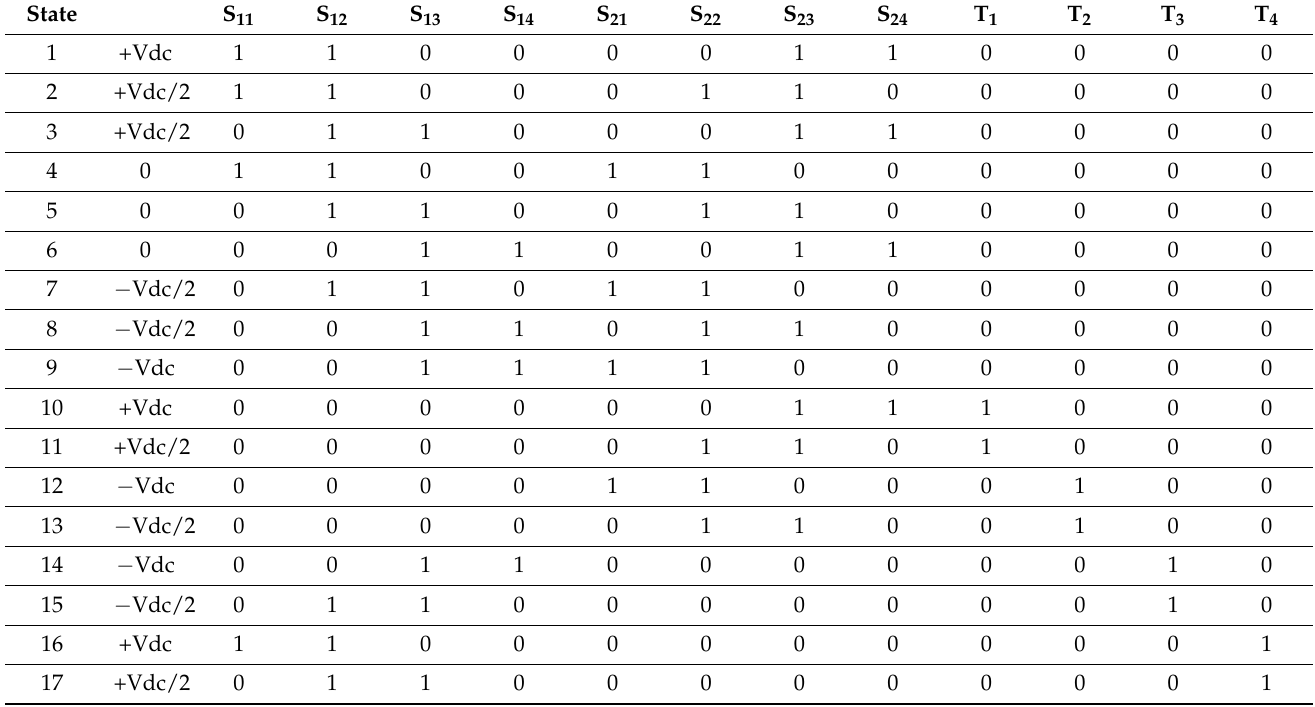
Table 3. Switching pattern corresponding to each voltage